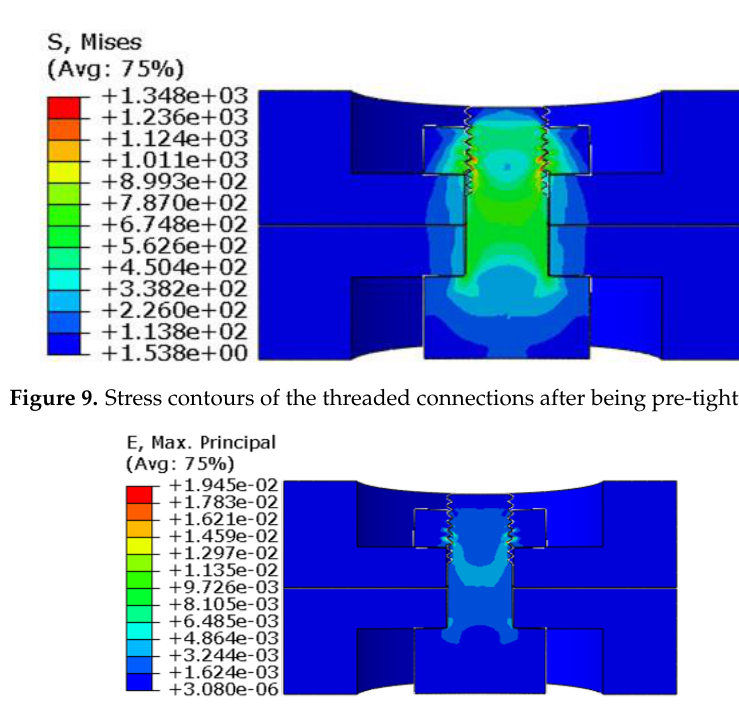
Figure 10. Strain contours of the threaded connections after being pre-tightened.